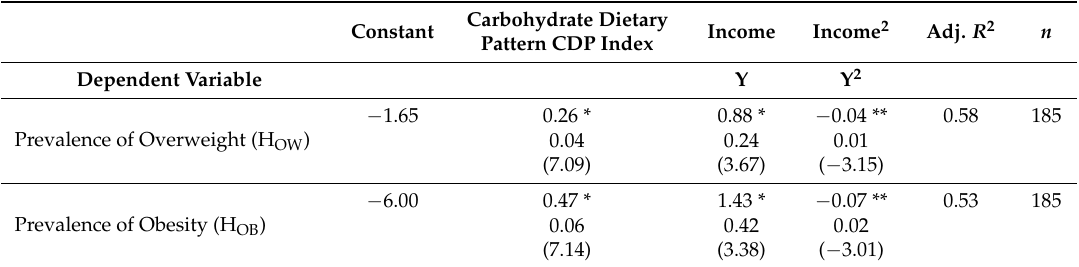
Table 4. Regression results: H OW and H OB regressed on CDP index and Y (double-log quadratic